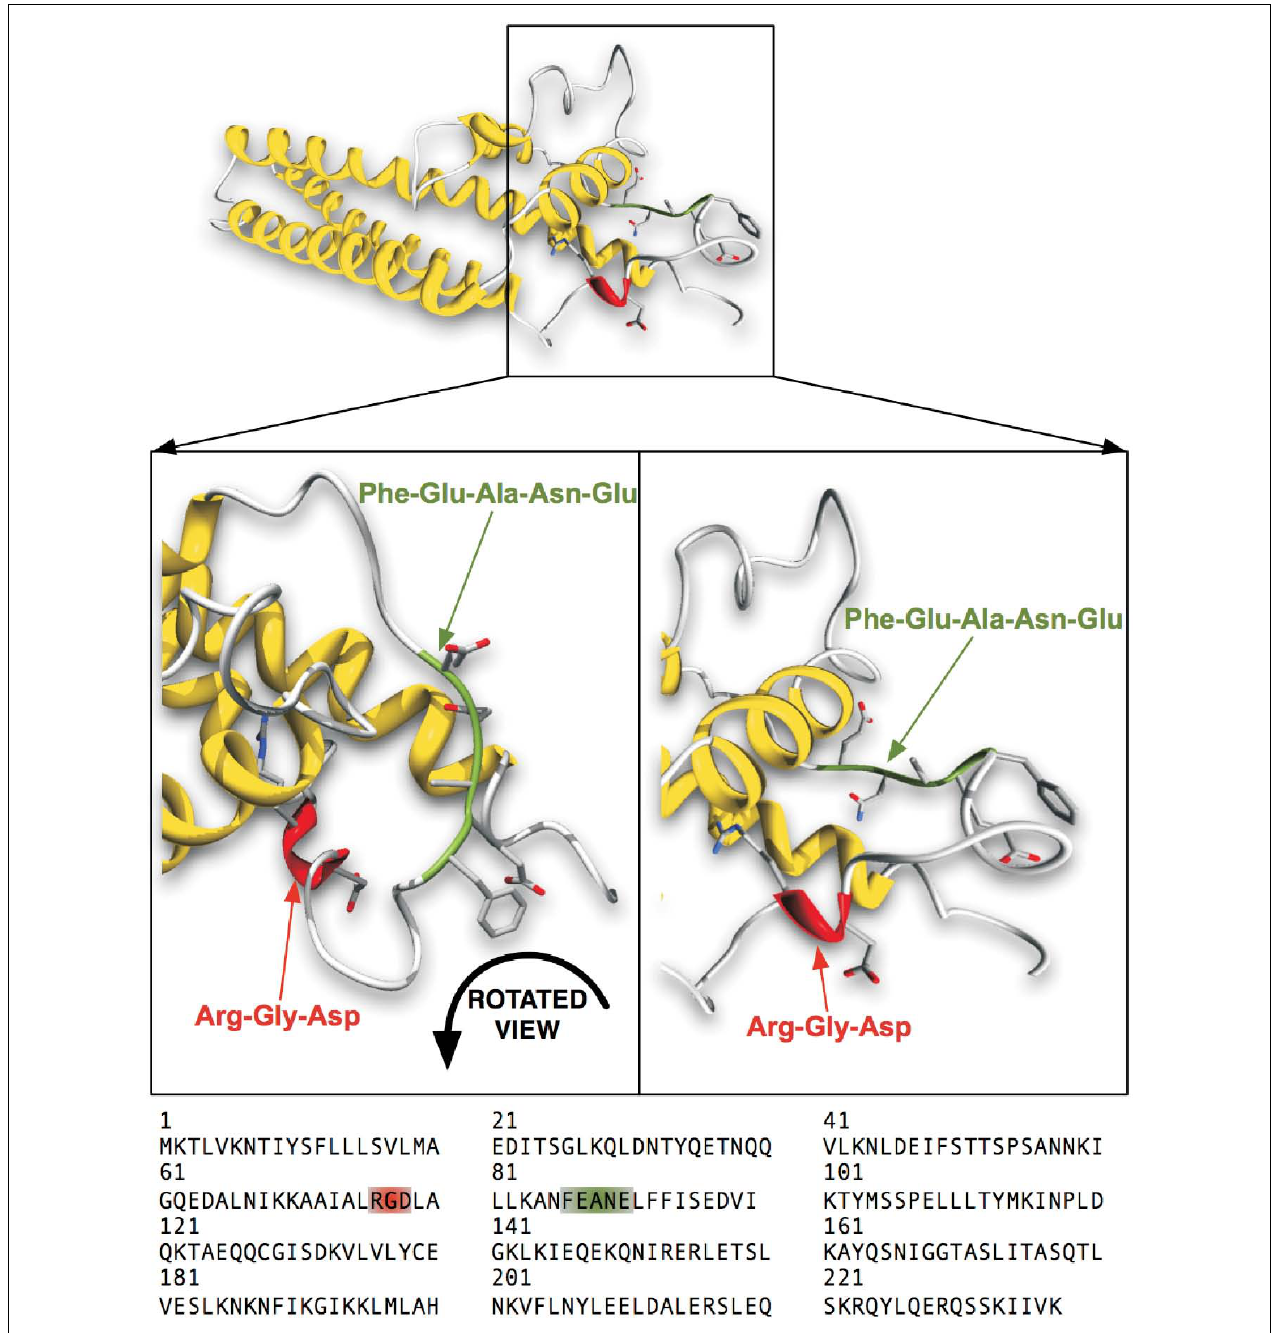
(here called RHS motif) is shown in a flexible loop, also exposed at the surface.The CagL homology model is derived from theVirB5 orthologTraC protein (PDB: 1R8I) encoded in plasmid pKM101 (Yeo et al., 2003; Backert et al., 2008).